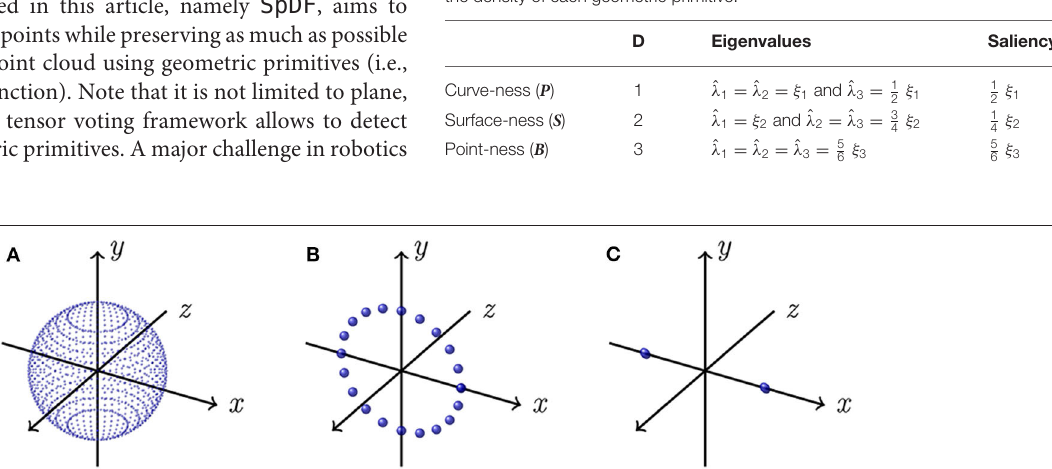
FIGURE 3 | Ideal simplified voting situations. (A) All points are uniformly distributed on a sphere ( D xy -plane ( D 2); (C) All points are uniformly distributed on the endpoints of a line segment along the x -axis ( D =